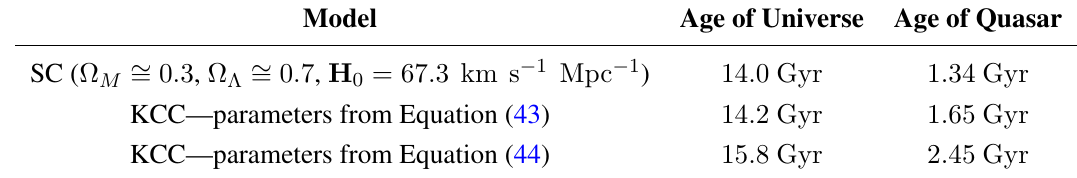
Table 2. Standard Cosmology and KCC estimates for the age of the Universe and of quasar APM